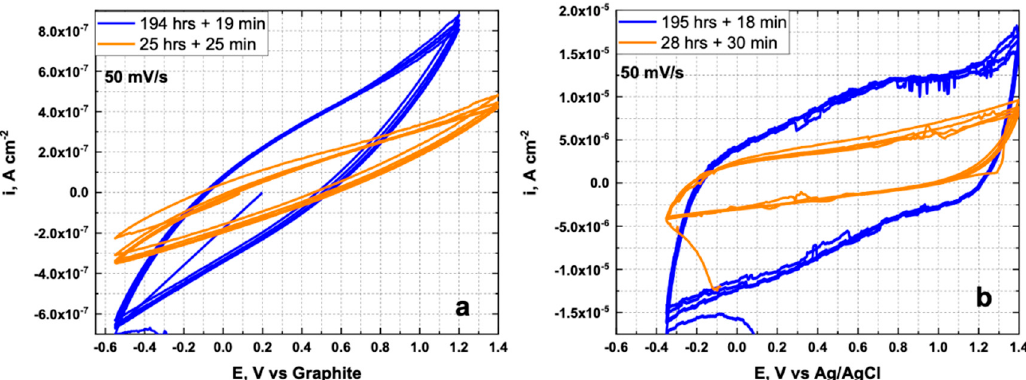
Figure 8. S 5: Electrochemical behavior of the MFC at different reaction times and under vacuum conditions at 50 mV / s under cathode direction. Wastewater was degraded in the anode chamber and a hydrochloric acid solution (0.1 M HCl, pH ≈ 1.8) was used as an electrolyte in the cathode chamber. Figures ( a ) and ( b ) correspond to the potentiostat setting A and C, respectively.